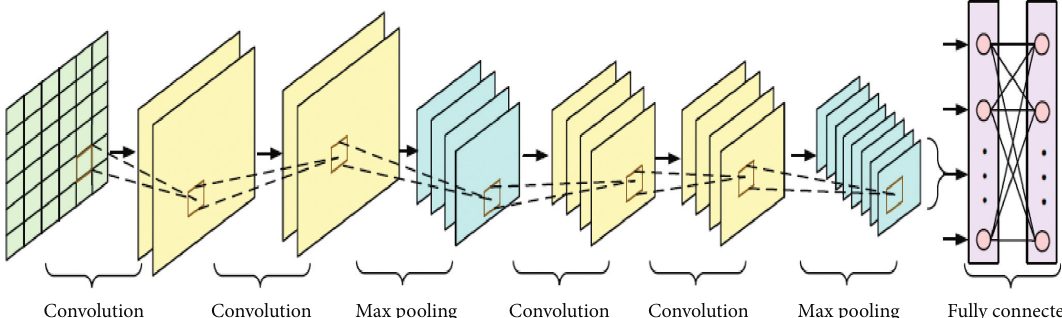
Figure 6: Structure of the convolution neural network (CNN) model for classification of Internet of Things (IoT)